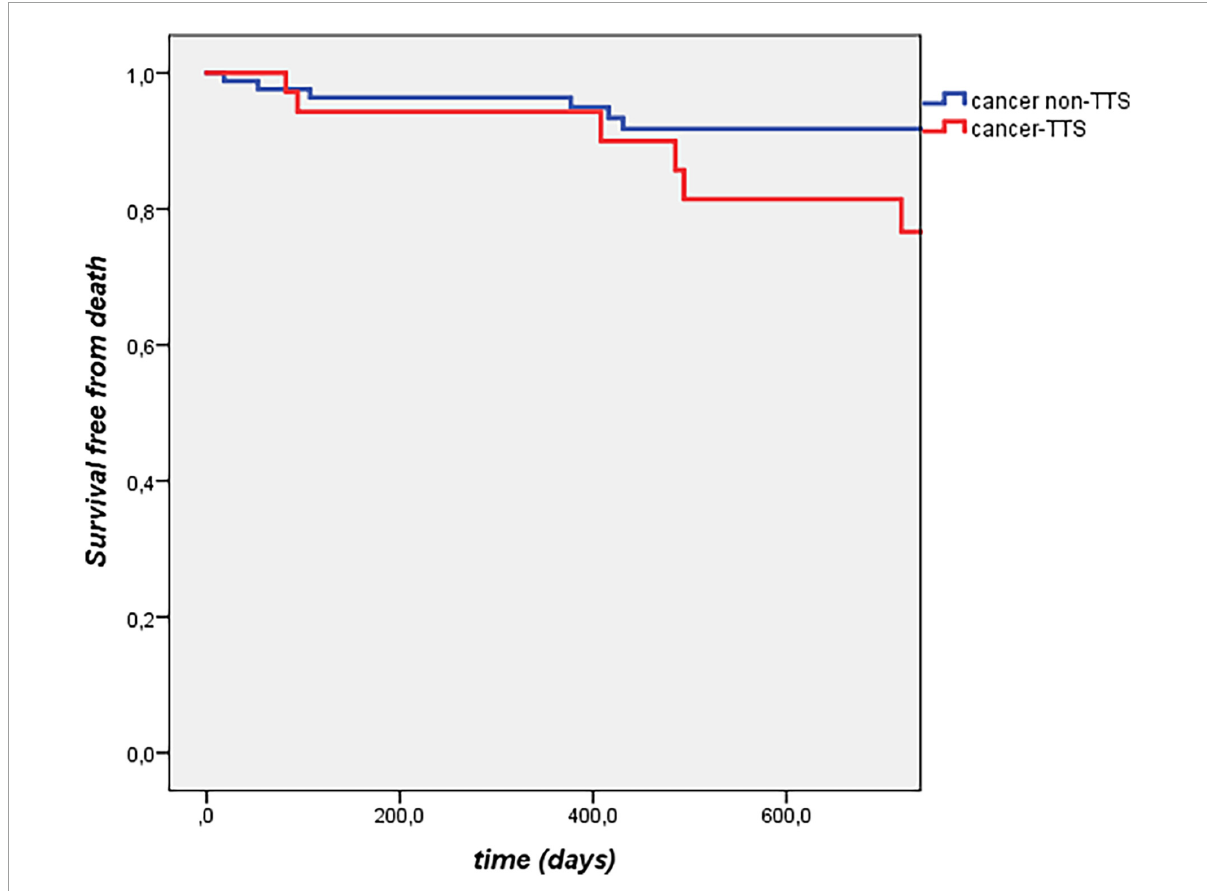
FIGURE1 Kaplan Meier analysis for all-cause